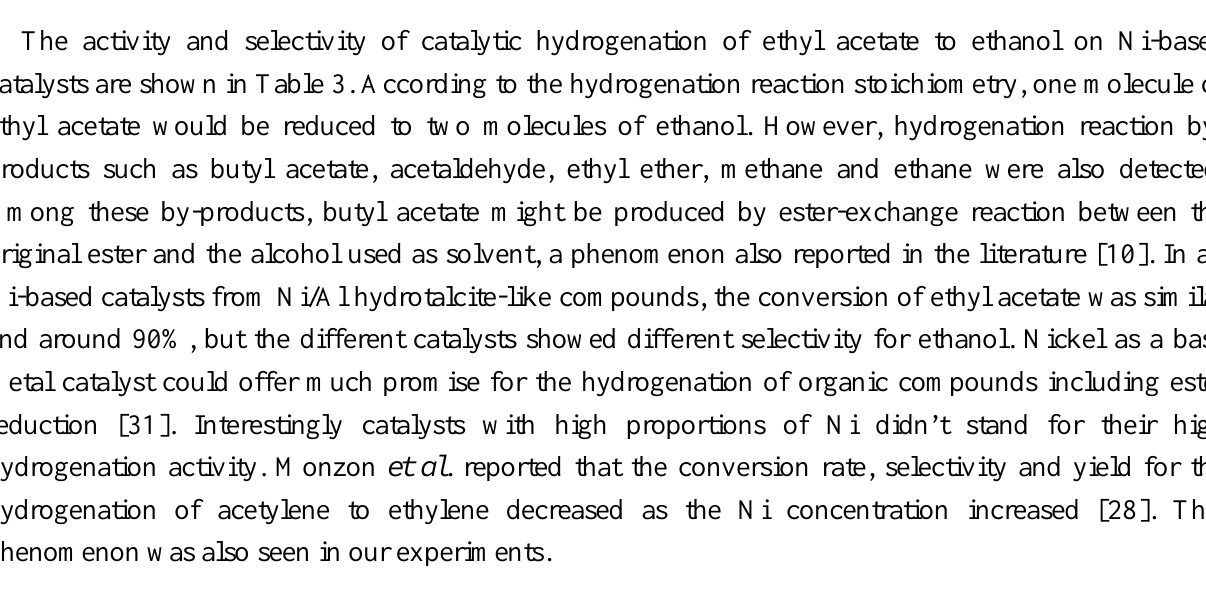
Table 3. Hydrogenation of ethyl acetate on Ni-based